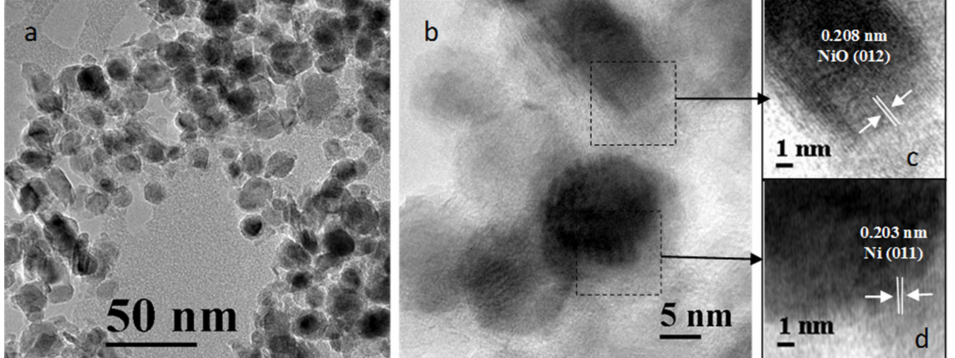
Figure 8. TEM images of the Ni@NiAlO x -4-600 sample at different magnifications ( a , b ); crystal lattice of NiO ( c ) and Ni ( d )